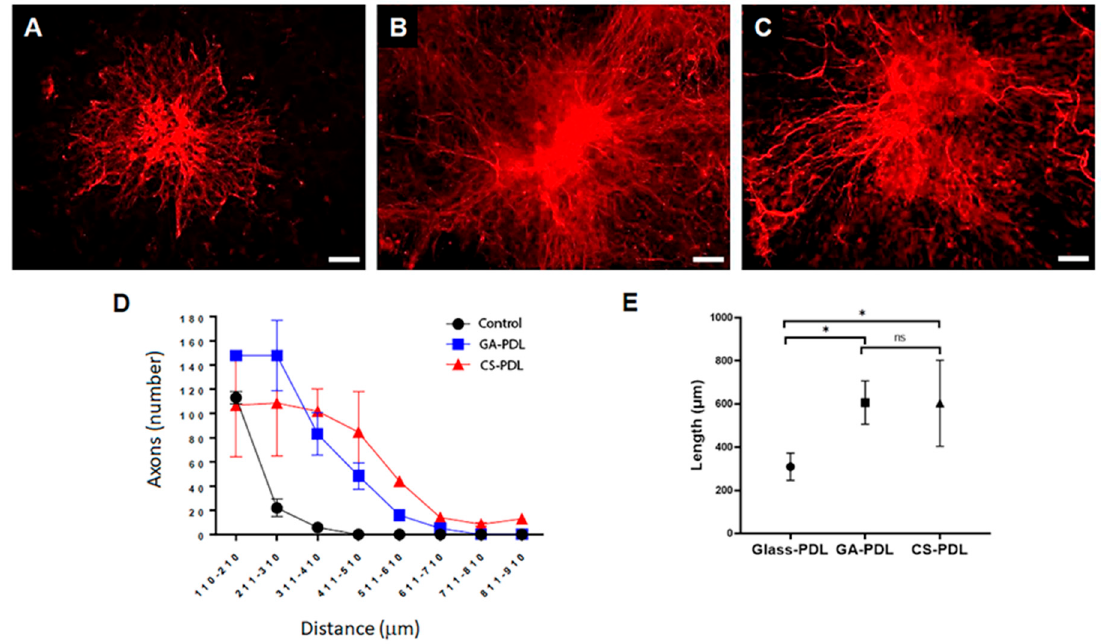
Figure 6. GA-PDL and CS-PDL promote axonal sprouting. Neurofilament M (NFM) immunofluorescence. ( A ) Glass coverslip. ( B ) GA-PDL. ( C ) CS-PDL. ( D ) Sholl analysis of axonal length. ( E ) Axonal maximal length. Glass-PDL N = 6, Mean = 310.00 ± 63.24, GA-PDL N = 3, Mean = 606.67 ± 100.16, t 7 = − 5.546, P = 0.001, CS-PDL N = 5, Mean = 604.00 ± 198.82, t 9 = − 3.451, P = 0.007. GA-PDL vs. CS-PDL: t 6 = 0.021, P = 0.984. Scale: ( A – C ) — 100 µ m. (* P < 0.05; ns = non-significant).